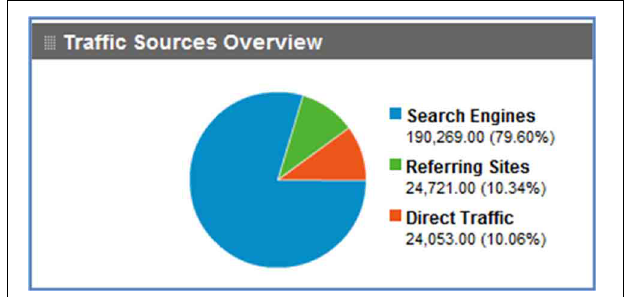
FIGURE 4 | Traffic sources to NeuroLex.org since December 2008. Direct traffic refers to a user typing “neurolex.org”into the browser or following a personal bookmark. Referring sites are visits where a user started at another site and clicked a link to arrive at NeuroLex.org.Search engines refer to any user that came to NeuroLex.org from a web search. Google searches made up 95% of the search engine traffic.